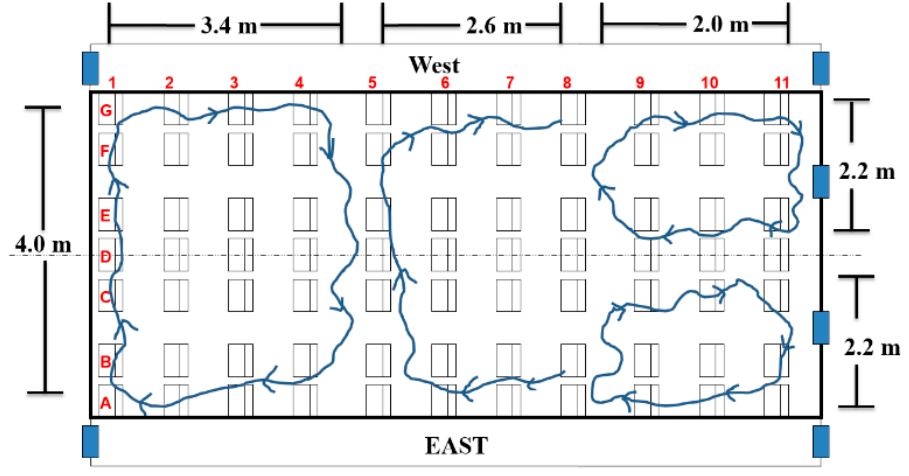
Figure 5. Results for airflow in the cabin with heated manikins [19].